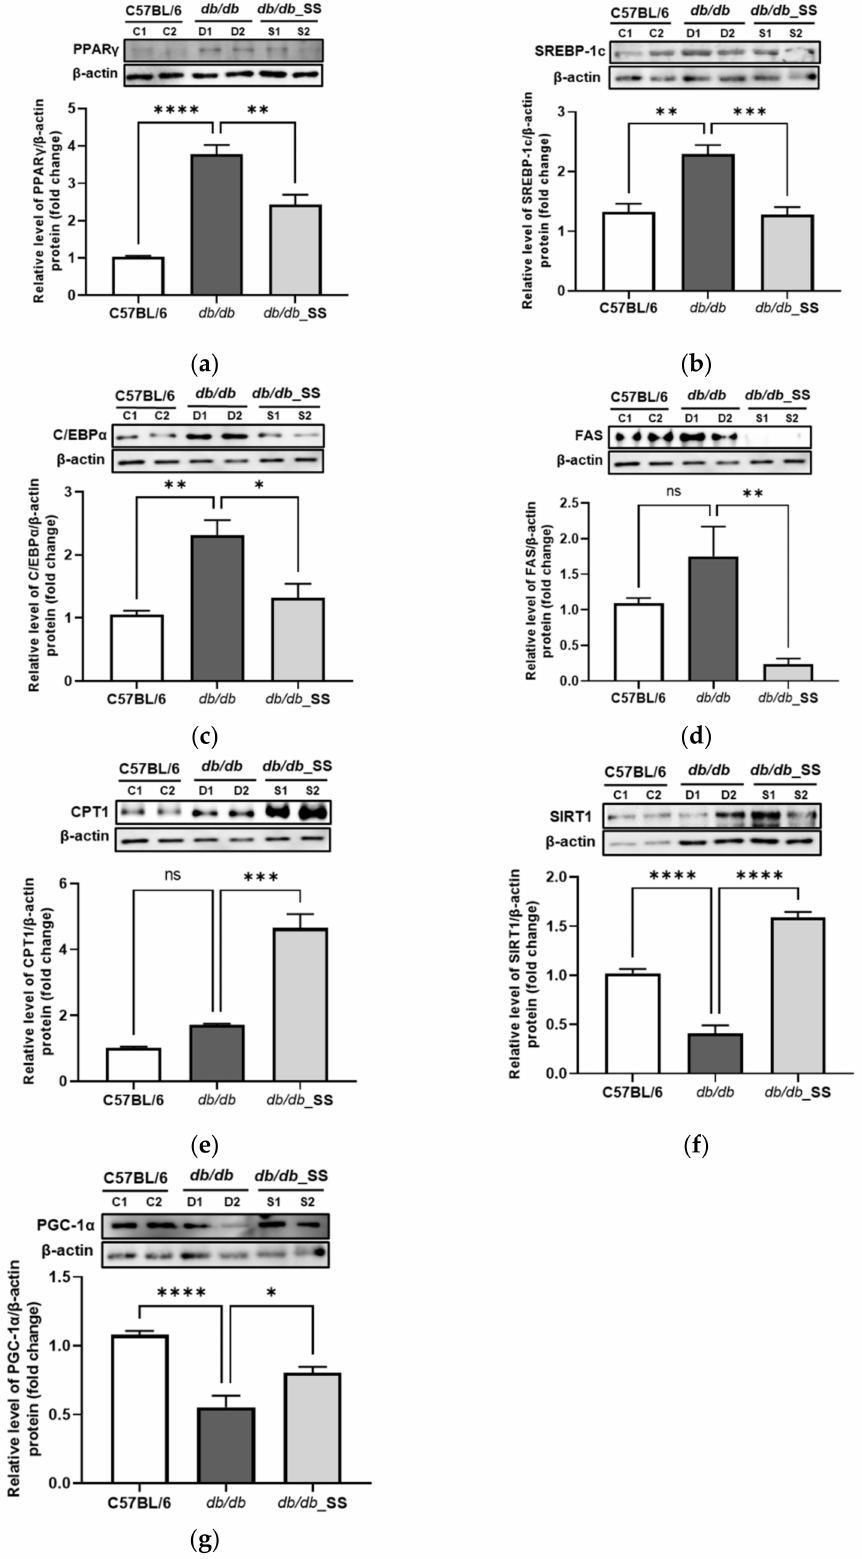
Figure 7. The effect of stevioside on the expression of the adipogenic and fatty acid oxidation related genes in mouse epididymal adipose tissue of C57BL/6 mice and db/db mice. ( a ) peroxisome proliferator-activated receptor gamma (PPAR γ ), ( b ) sterol regulatory element-binding transcription factor-1c (SREBP-1c), ( c ) CCAAT/enhancer-binding protein alpha (C/EBP α ), ( d ) fatty acid